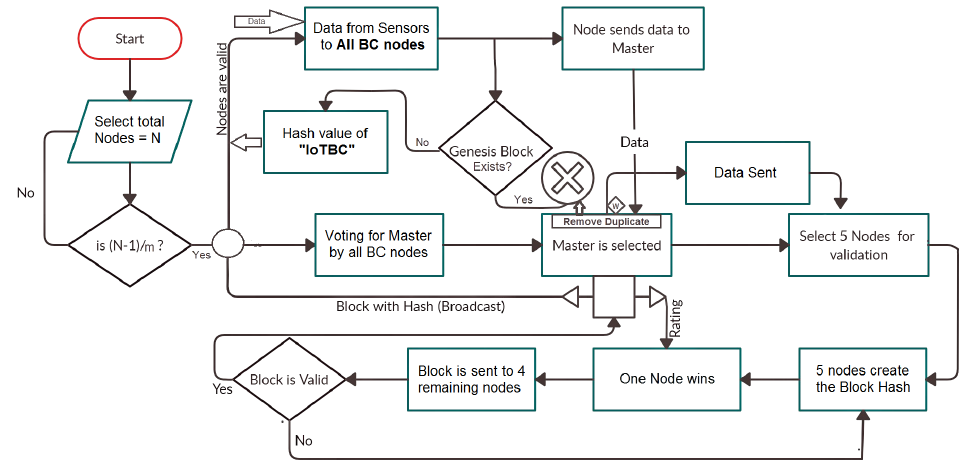
Figure 6. CBCIoT flow